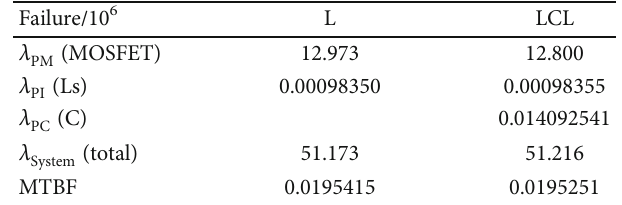
Table 7: Reliability of L fi lter vs. LCL fi